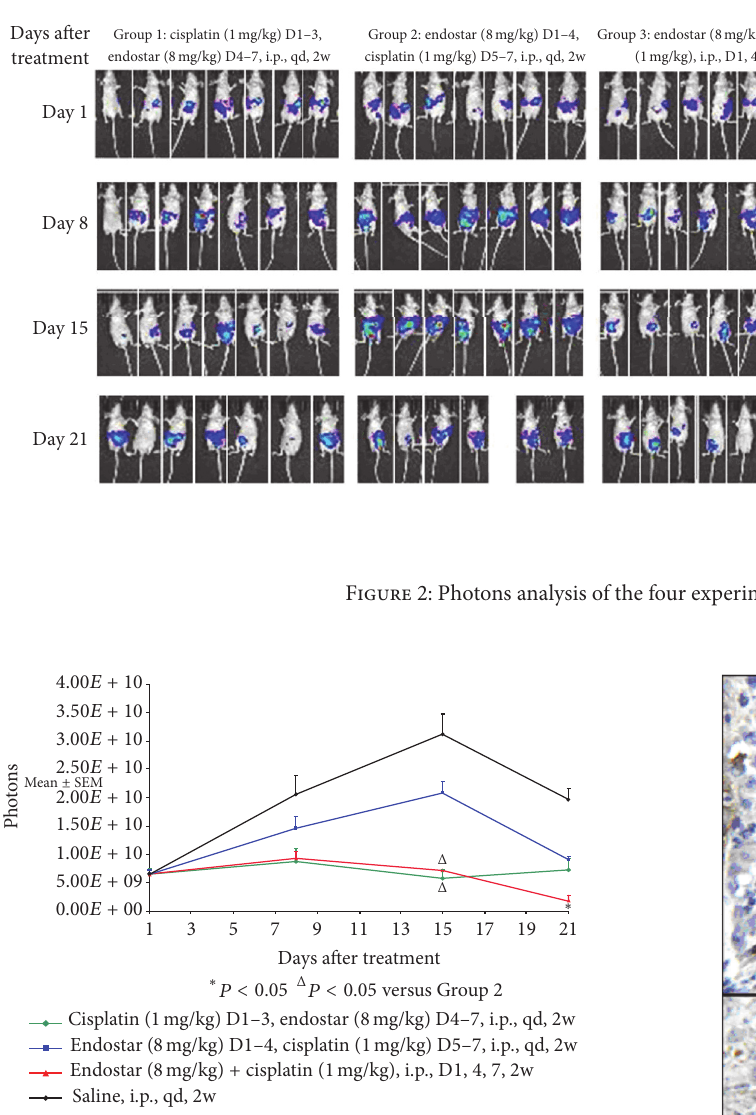
Figure 3: Photons analysis of the experimental groups by repeated measures process of the general linear model.